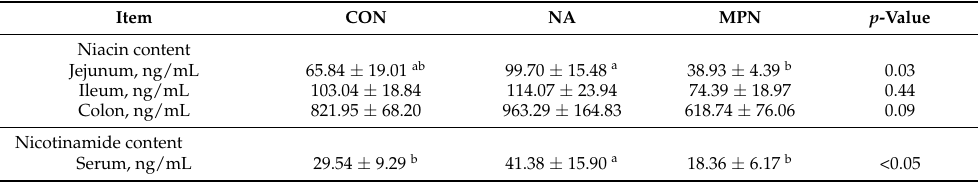
Table 4. The niacin and nicotinamide content in the intestinal digesta and